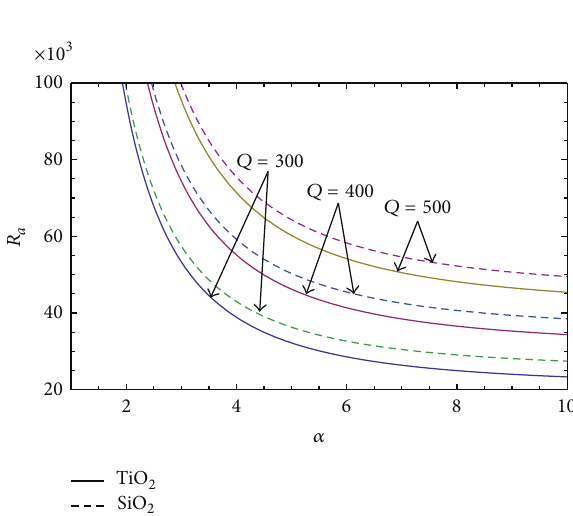
Figure 1: Effect of 𝑄 on metallic nanoparticles.